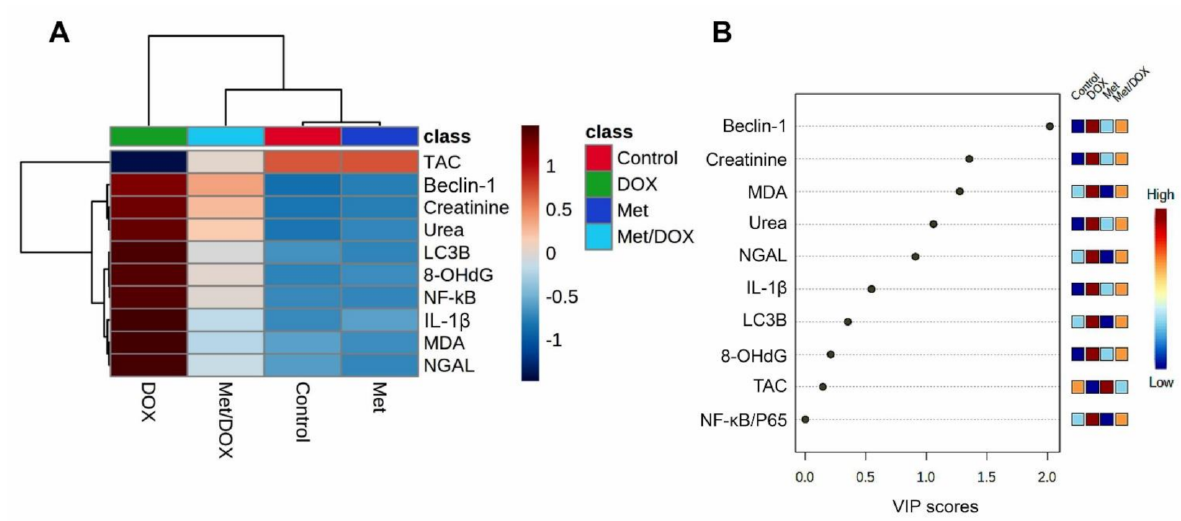
Figure 8. Hierarchical clustering heatmap and variable important project (VIP) scores provide an intuitive visualization of all data sets. ( A ) Clustering heatmap for the variable averages and different treatments; The concentration levels are represented by each colored cell on the map, with varied averages in rows and various treatments in columns. ( B ) Variable important project (VIP) score; the extent to which different factors contribute. A colored scale with the highest (red color) and lowest (blue color) value designates the contribution strength (blue color). Dark red (highest value) is at the top of the gradient scale, while blue is at the bottom (lowest